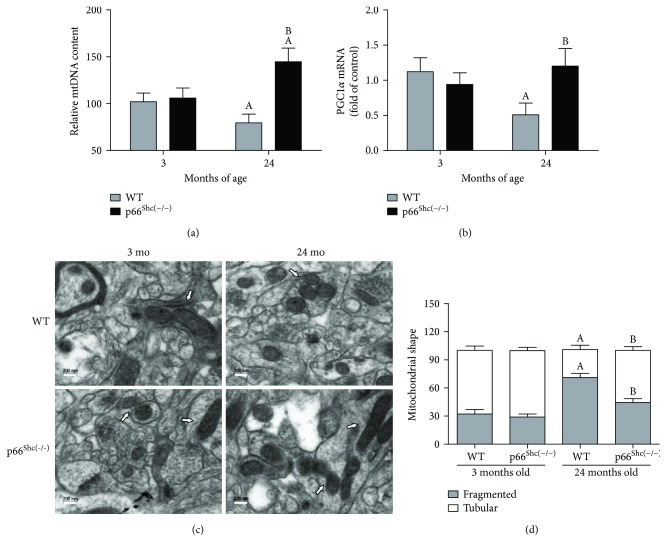
Effects of aging on mitochondrial content, biogenesis, and structure in p66Shc(−/−) mouse brain. (a) Quantification of mtDNA and nuclear DNA by qPCR. (b) The mtDNA/nDNA ratio was calculated from 3- and 24-month WT (grey) and p66Shc(−/−) (black) groups. The mRNA levels of PGC-1α were measured in TRIzol-treated brain extracts from all the studied groups; GADPH mRNA was used as standard (n = 6). (c) Mitochondrial morphology was evaluated using electron microscopy of fixed brain slices (n = 5 for each experimental group) (magnification:×20,000). (d) At least 300 tubular and fragmented mitochondria were counted per arbitrary area. The percentage distribution of tubular and fragmented brain mitochondria was determined in a minimum of 8–10 random fields at ×4400 magnification to ensure a representative area of analysis (n = 5). Mitochondria whose length was more than three times their width were considered tubular, while the remaining round mitochondria were considered fragmented. The analysis was performed by two different investigators in a blinded fashion. Values represent the mean ± SEM; A represents p < 0.05 compared to the 3-month-old group, B represents p < 0.05 between 24-month-old WT and p66Shc(−/−) groups, one-way analysis of variance (ANOVA) and Bonferroni post hoc test.